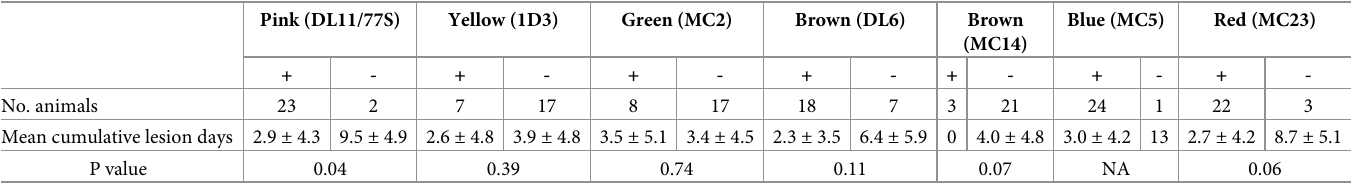
Table 2. Lesion days based on antibodies produced to individual epitopes (cid:3) .